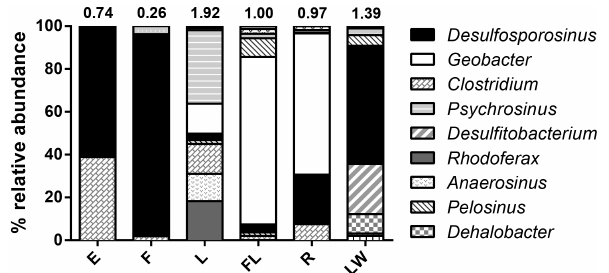
Figure 2. Genus-level taxonomic identification of 16S rRNA genes amplified from DNA extracted from second-generation Fe-reducing enrichments incubated at 4 ◦ C and originated from Engabreen (E), Finsterwalderbreen (F), Leverett (L), “fresh” Leverett (FL), Russell (R) and Lower Wright (LW) glaciers. Data show genera that rep- resent more than 1% of combined datasets. All genera known to include strains capable of microbial iron reduction, and genera that are assigned to 5% or more of sequences for each sample, are in- cluded in the legend. Shannon’s diversity indices calculated using the complete datasets for each sample are given above the corre- sponding bar in the